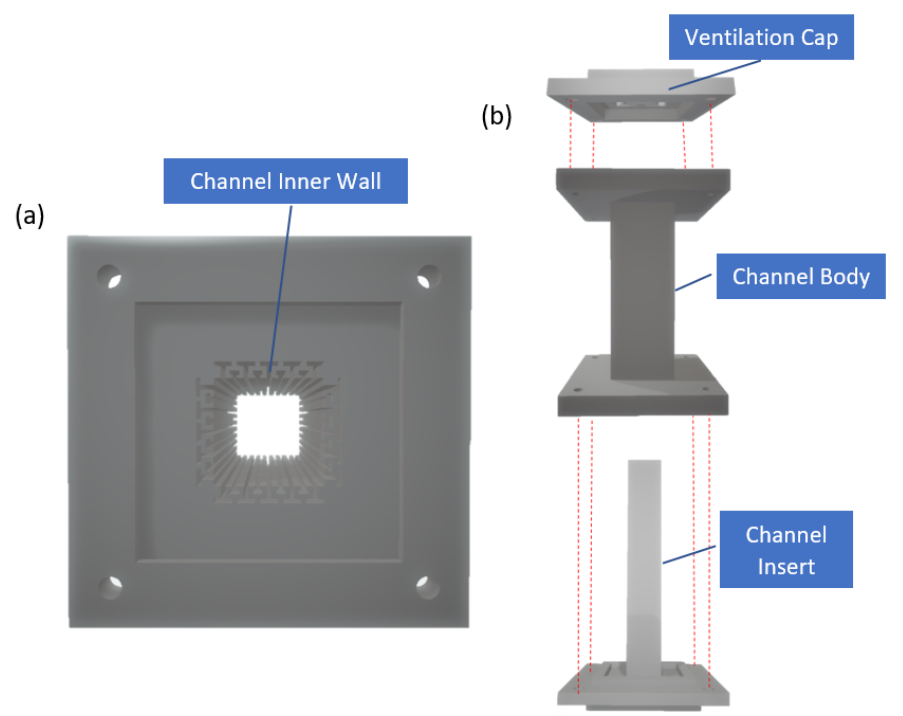
Figure 3. The coating of the inner channel walls with PDMS: ( a ) Rigid and porous structure created to hold the PDMS inside the channel, and ( b ) Insert placed inside the channel for molding the PDMS around the walls of the channel.